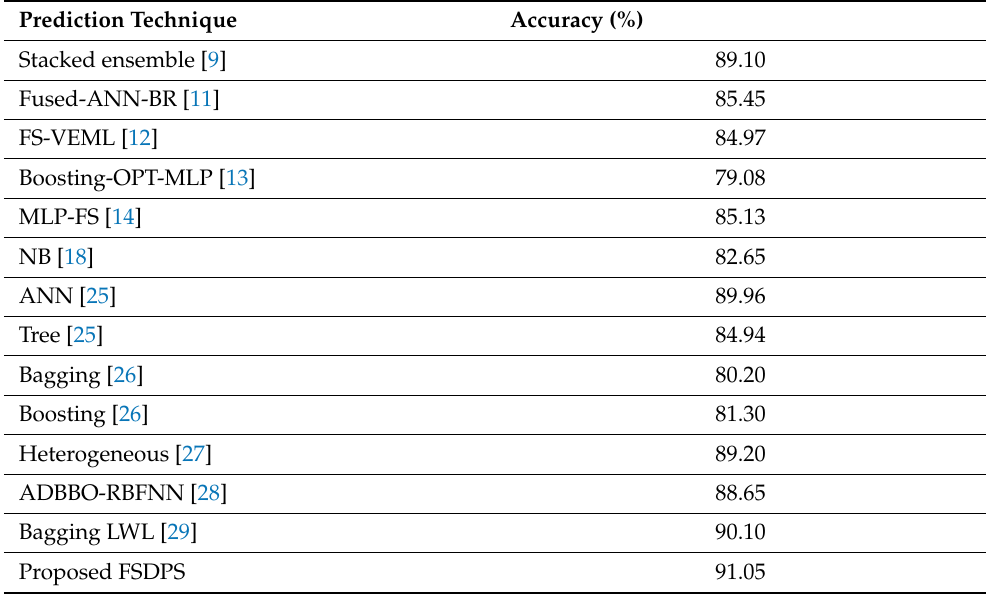
Table 11. Performance comparison of the proposed ISDPS with the other